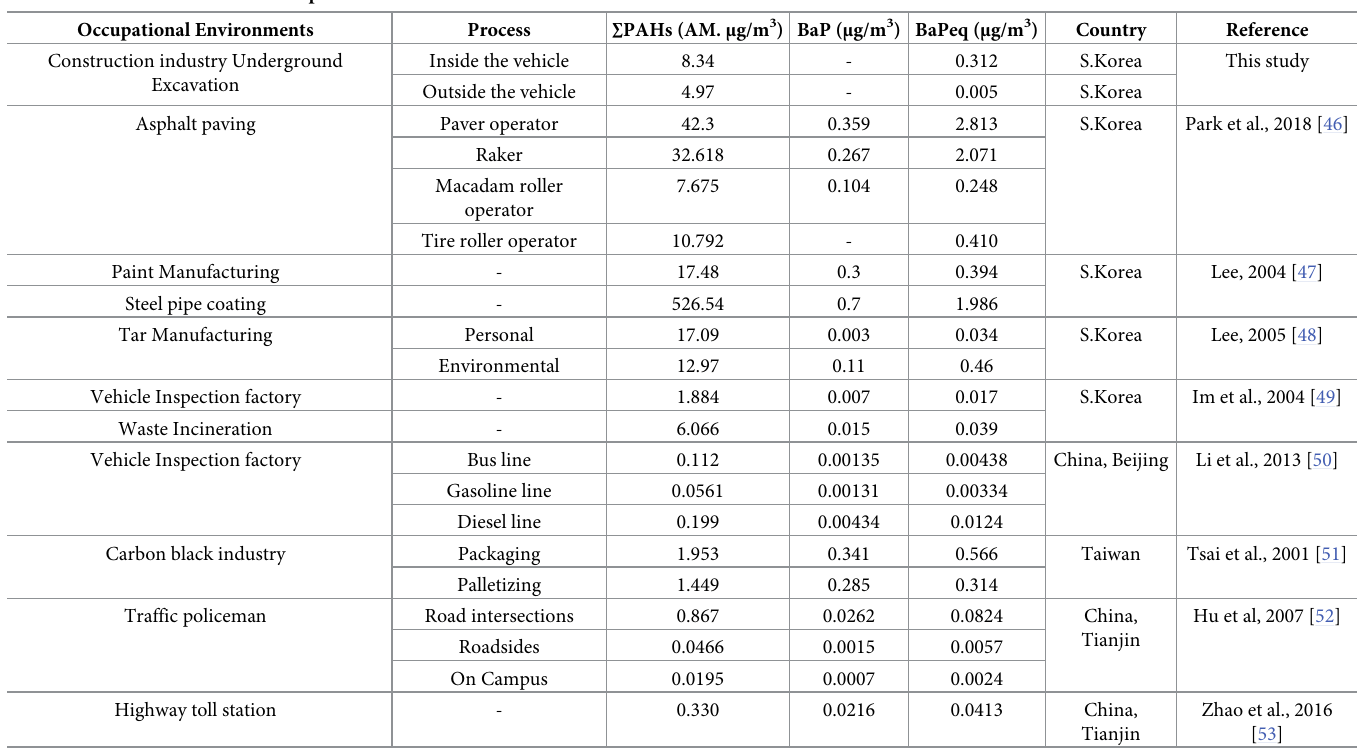
Table 8. The PAHs concentration reported in earlier